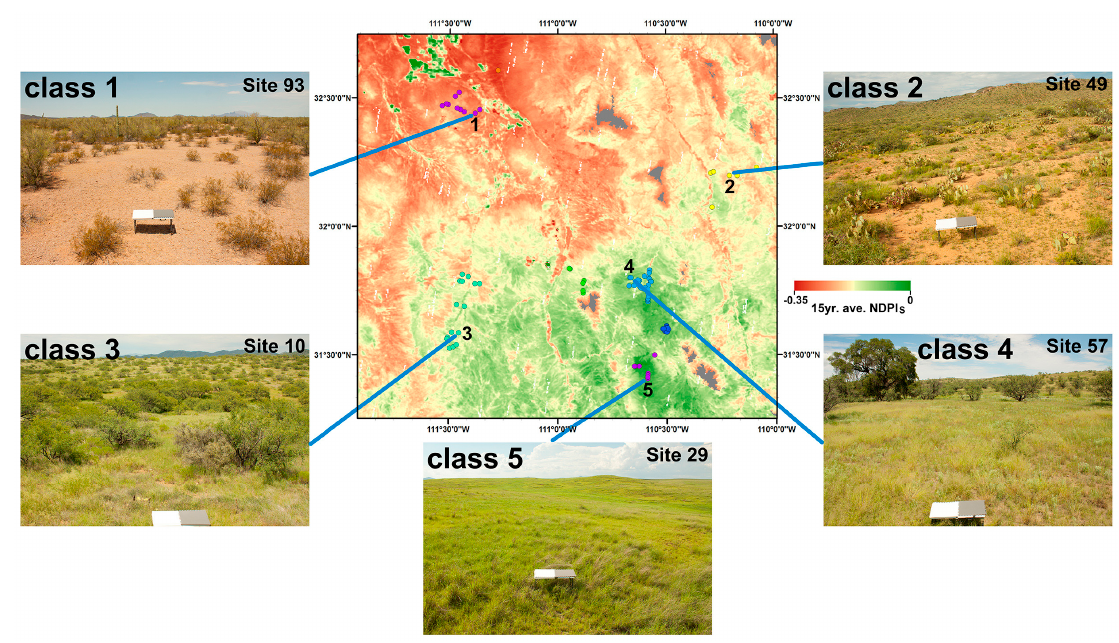
Figure 6. Color dots on the MODIS-derived map of the 15-year average NDPI s indicate locations of the 92 field sites used for validation. The photographs represent each qualitative landscape category, or class, of perennial C 4 grass cover, ranging from essentially no cover (class 1) to dense, continuous cover (class 5).